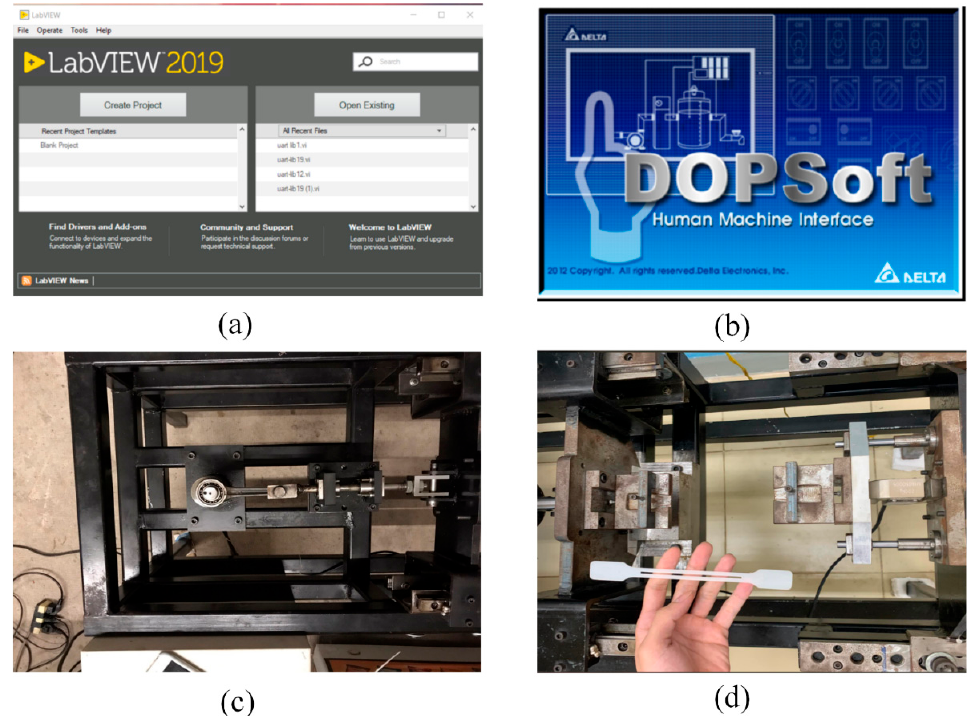
Figure 4. The experimental setup of the test: the LabVIEW software for controlling the loadcell ( a ), the DOPSoft software version 1.00.07, Delta Electronics Taiwan for managing the motor ( b ), the fatigue machine without a sample ( c ), and the fatigue sample before assembly ( d ).